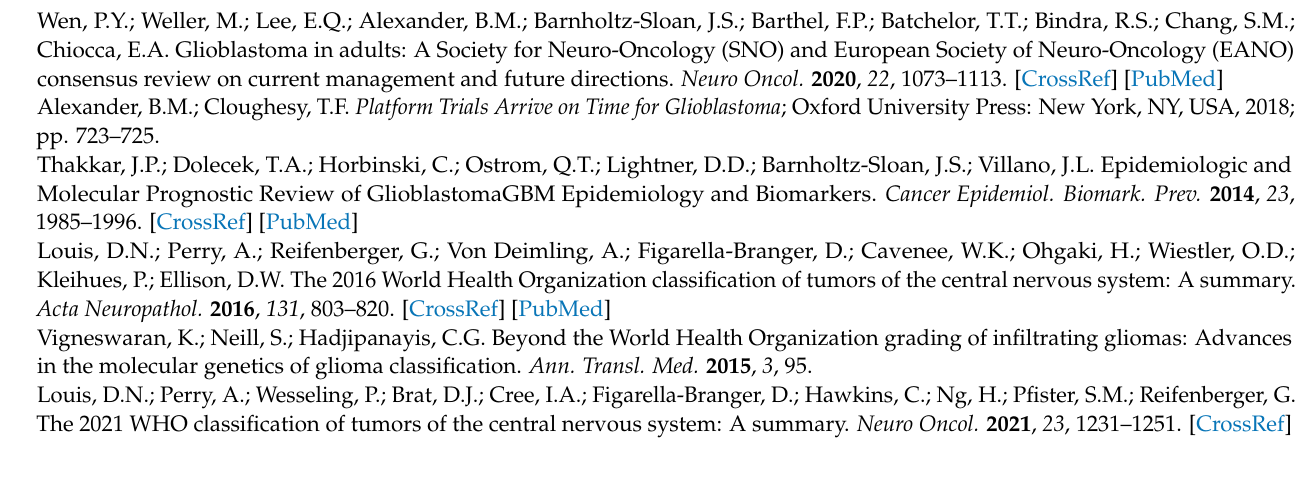
Table S3. The complete result of multi-machine learning algorithms, feature selection, and multi- segmentation approaches in discriminating IDH-mutant grade-4 astrocytomas from IDH wild-type GBMs of original